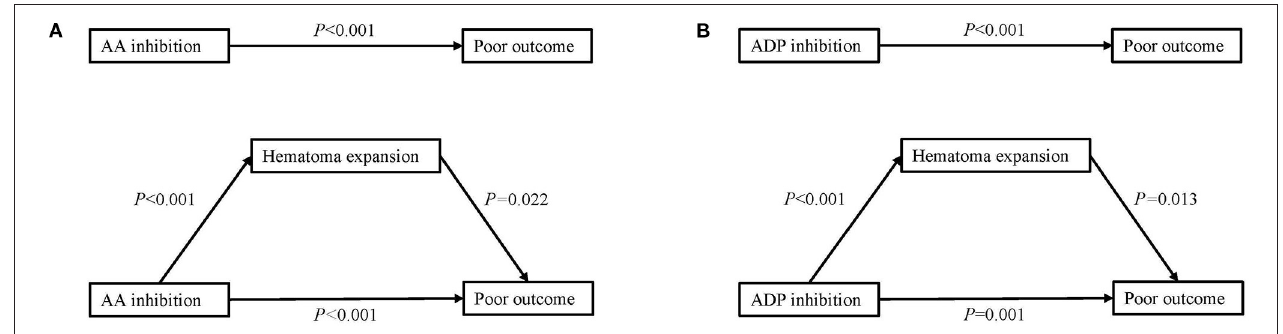
FIGURE 3 | Mediation analysis of the association of platelet inhibition with poor outcome with hematoma expansion as a mediator. (A) Mediation analysis of AA inhibition in poor outcome by hematoma expansion. (B) Mediation analysis of ADP inhibition in poor outcome by hematoma expansion. AA, arachidonic acid; ADP, adenosine